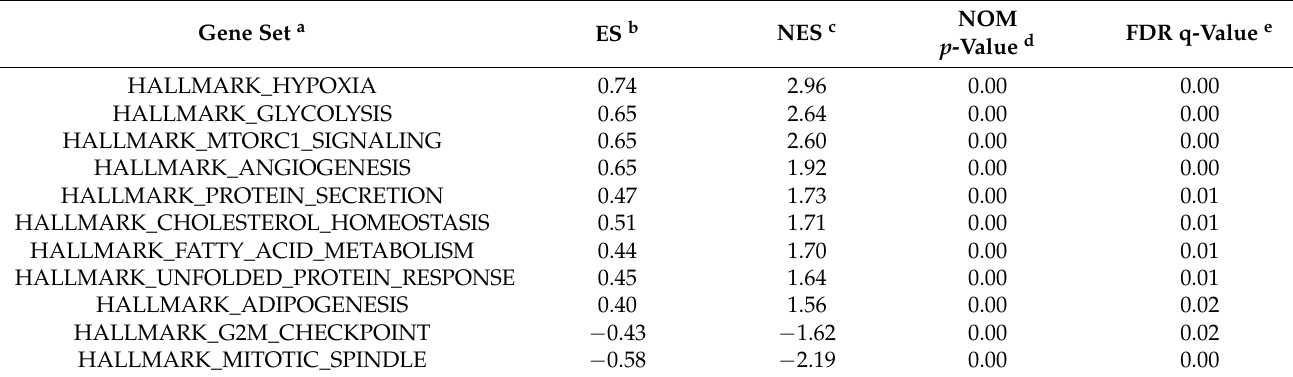
Figure 6. Enrichment plots for custom gene sets found significantly enriched in two distinct gene set enrichment analysis (GSEA) experiments. The plots report the significant enrichment of the CANGELOSI_HYPOXIA_UP gene set in SK-N-BE(2)c cells cultured under hypoxia ( a ) or with mTORC complex inhibitor PP242 ( b ). The experimental groups used to perform GSEA are reported on top of the plots. The enrichment plot shows the gene set name (top), the running enrichment score (green curve), the positions of the gene set hits on the rank ordered list in GSEA (black bars), and the rank ordered list according to the signal-to-noise metric (bottom). Red indicates the highest signal-to-noise values, whereas blue indicates the lowest ones. Table 2. Hallmark gene sets enriched in NB cell lines cultured under hypoxia for 24